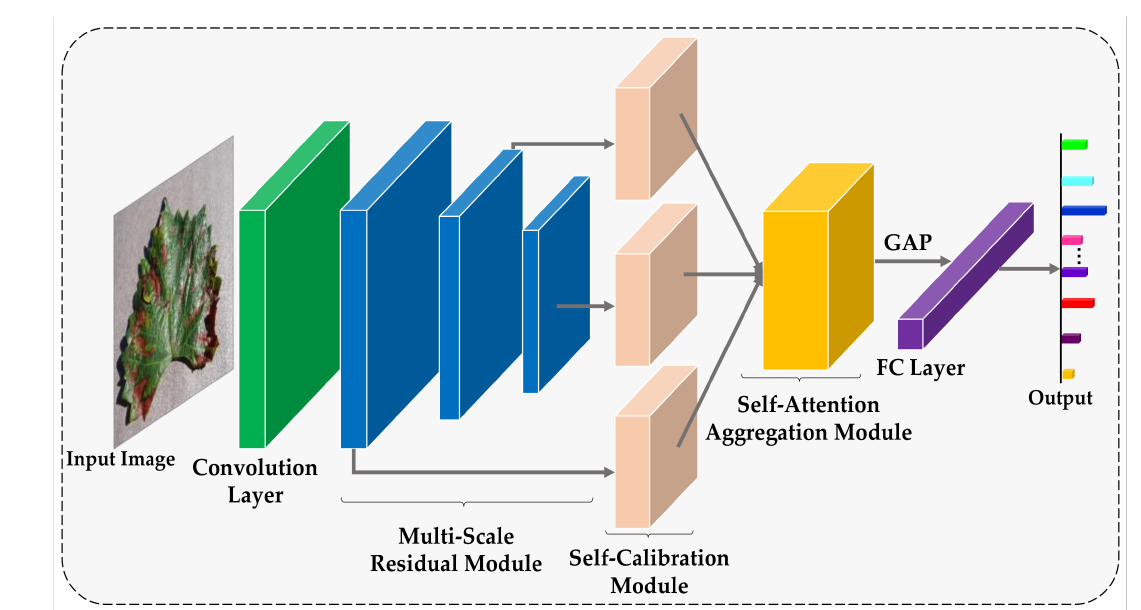
Figure 1. The framework of the proposed